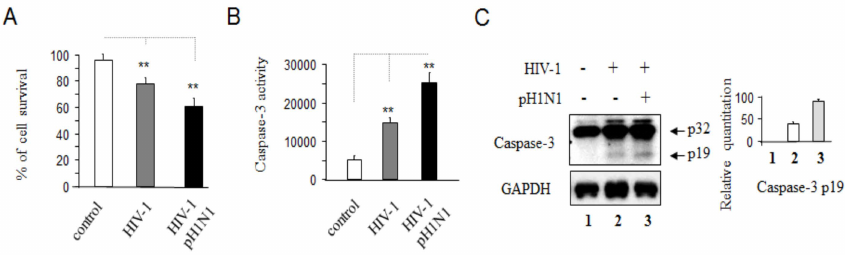
Figure 1. Pandemic influenza A (H1N1) virus infection can induce cell death through apoptosis in HIV-1-infected cells. Jurkat cells were infected with HIV-1 (MN) for 3 days and then infected with a pandemic influenza A (H1N1) virus (pH1N1) stock, A/California/04/2009, and cultured for another 3 days. Cells incubated without viruses were used as control. ( A ) Cell viability relative to control was determined by Trypan blue exclusion; ( B ) The total cell lysates were subjected to test caspase-3 activities with EnzChek®Caspase-3 Assay Kit #1-Z-DEVD-AMC Substrate from Invitrogen (grand Island, NY, USA), which was performed according to the manufacturer’s instruction; ( C ) The total cell lysates with RIPA buffer were subjected to Western blot analysis to detect caspase-3.The unpaired Student’s t test was used for data analyses and a value of p < 0.01 was considered very significant (**) relative to